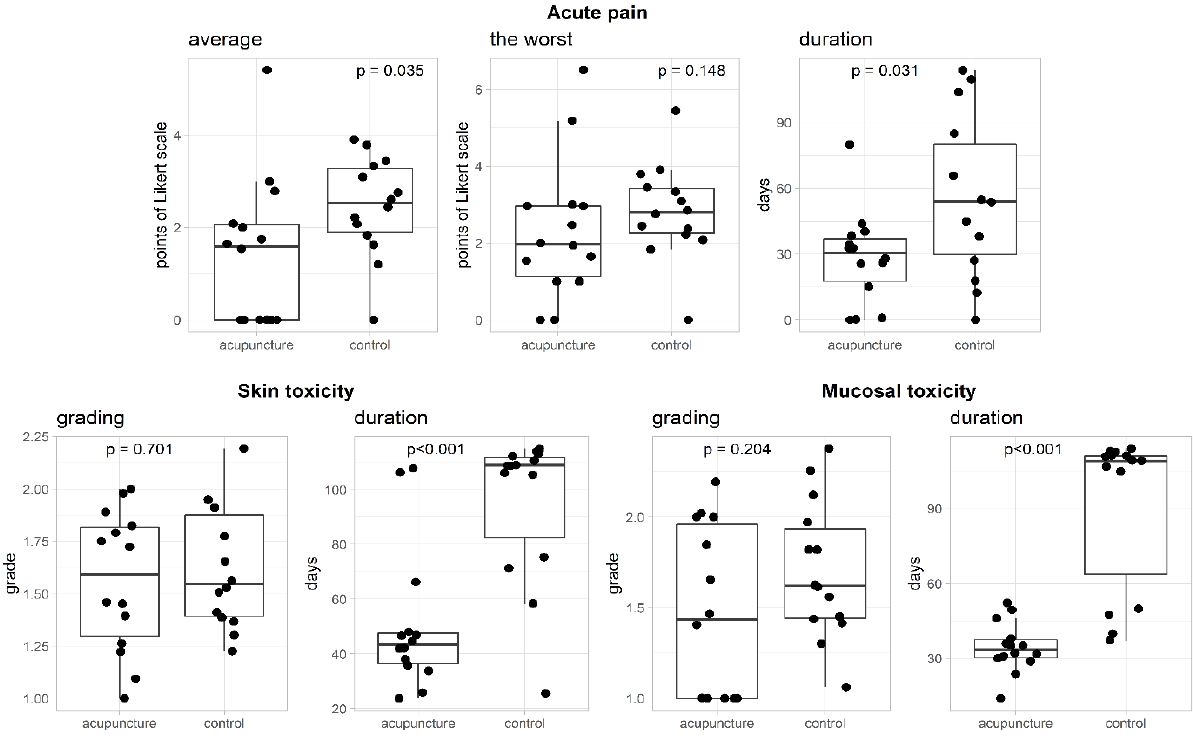
Fig. 2. Differences of outcomes in listed variables between standard treatment arm and patients with additional